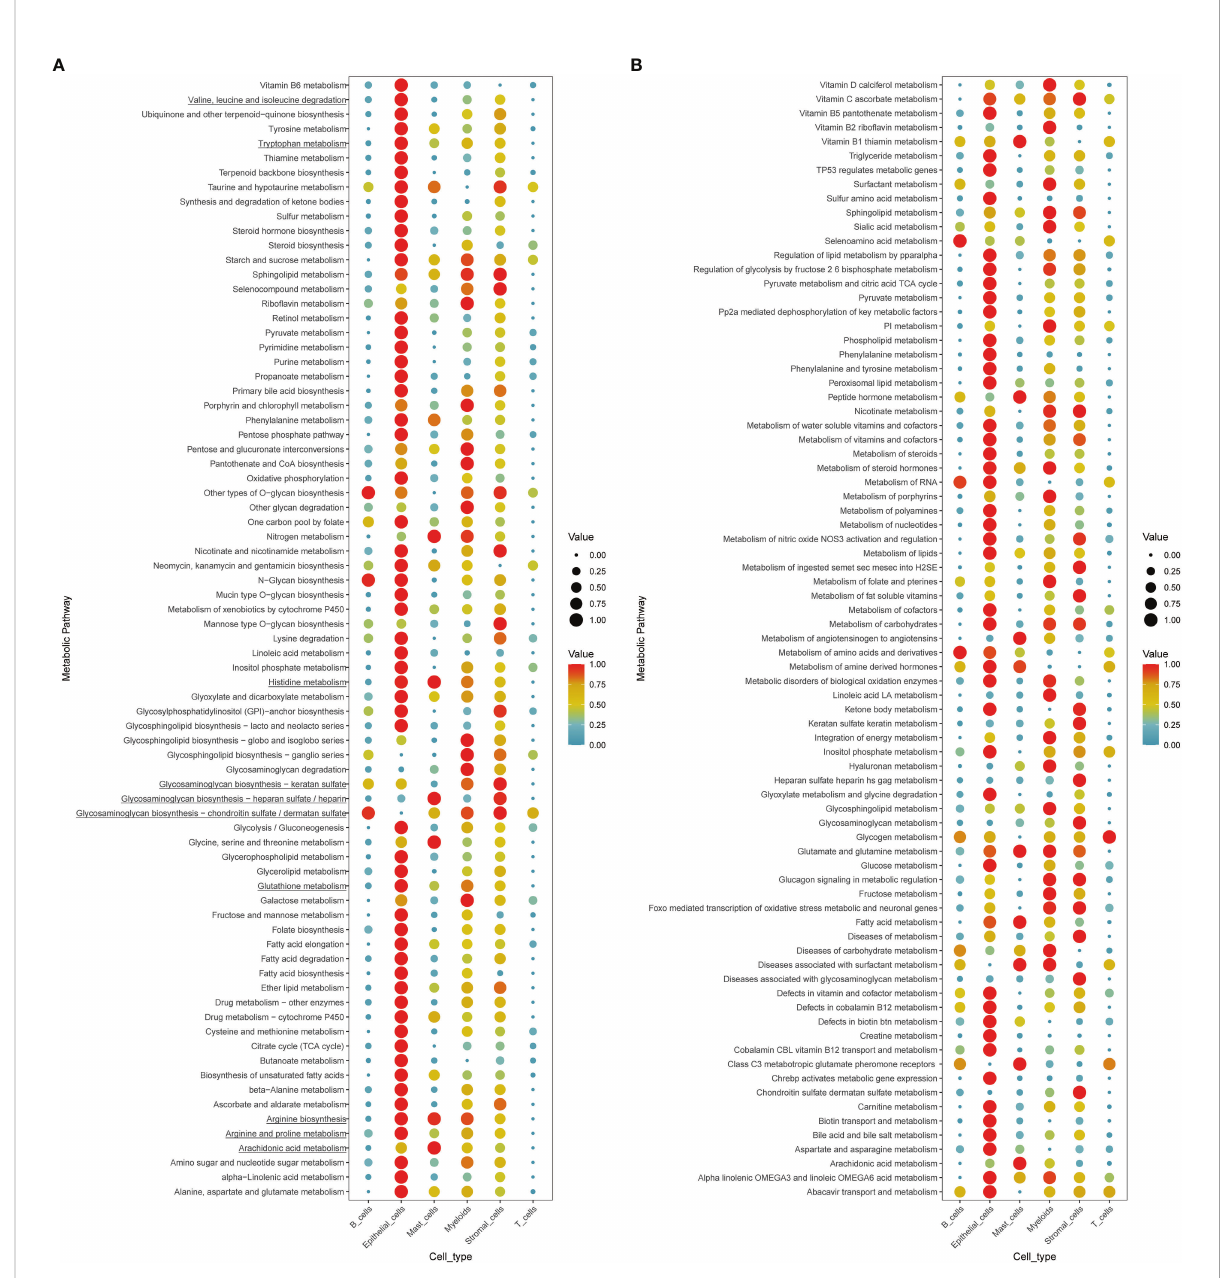
FIGURE 6 Exploration of the cell type-speci fi c metabolic activity landscape with single-cell data. (A, B) Metabolic activity of different cell types in single- cell sequence